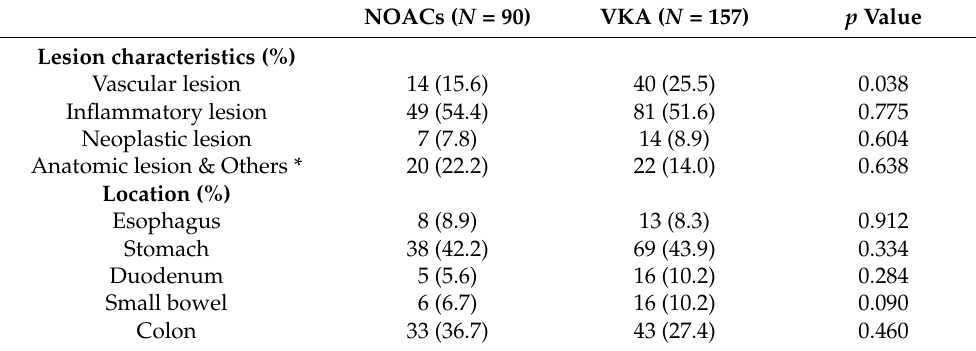
Table 3. Lesion characteristics and location of GI bleeding in patients with NOACs or VKA.